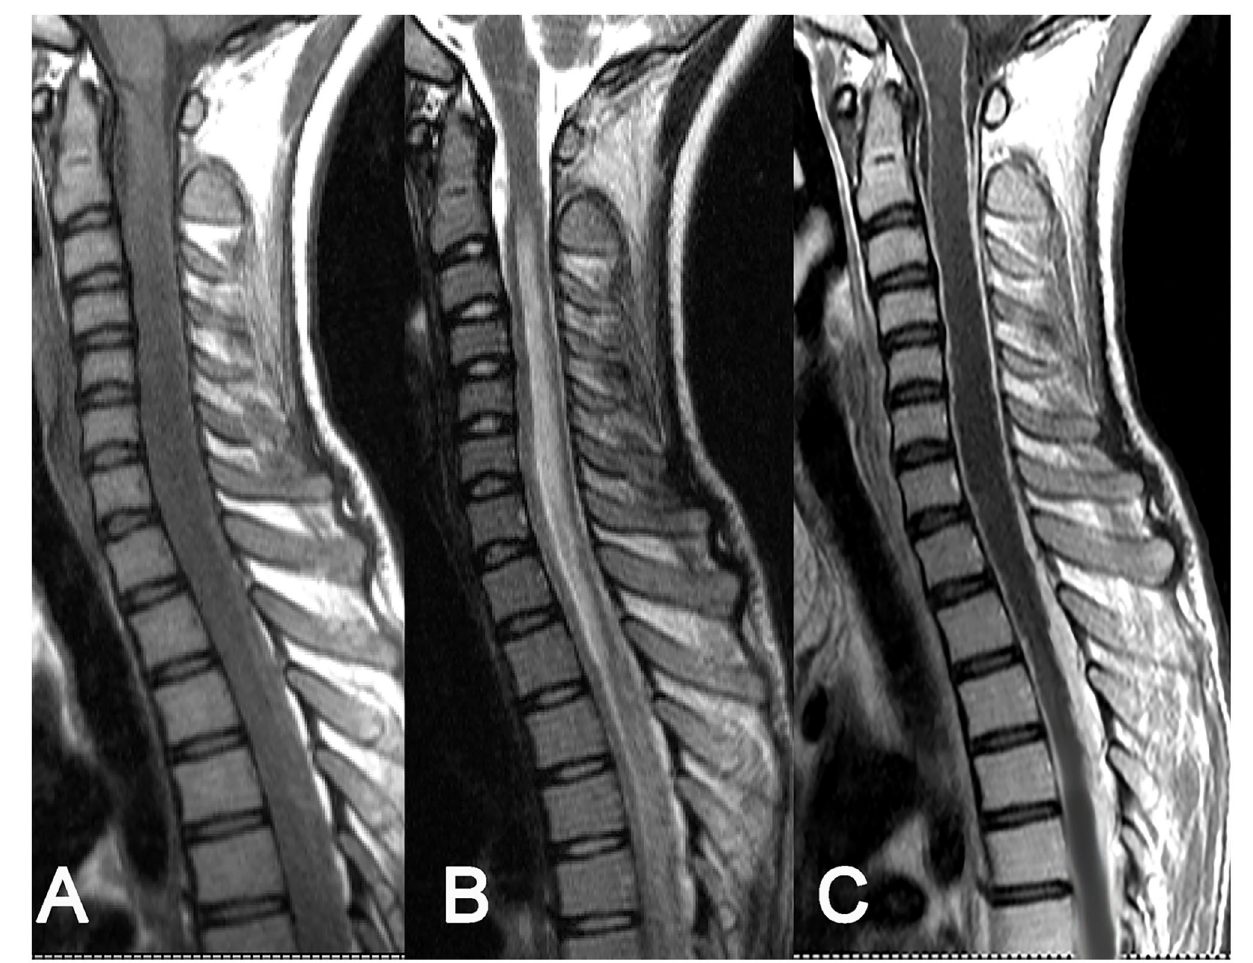
FIGURE 2 | Intradural extramedullary tuberculoma of the thoracic spinal cord. A lesion having a longitudinal fusiform shape: (A) isointense on T1WI, (B) isointense on T2WI, and (C) obvious homogeneous enhancement after contrast enhancement, accompanied by diffuse enhancement of spinal